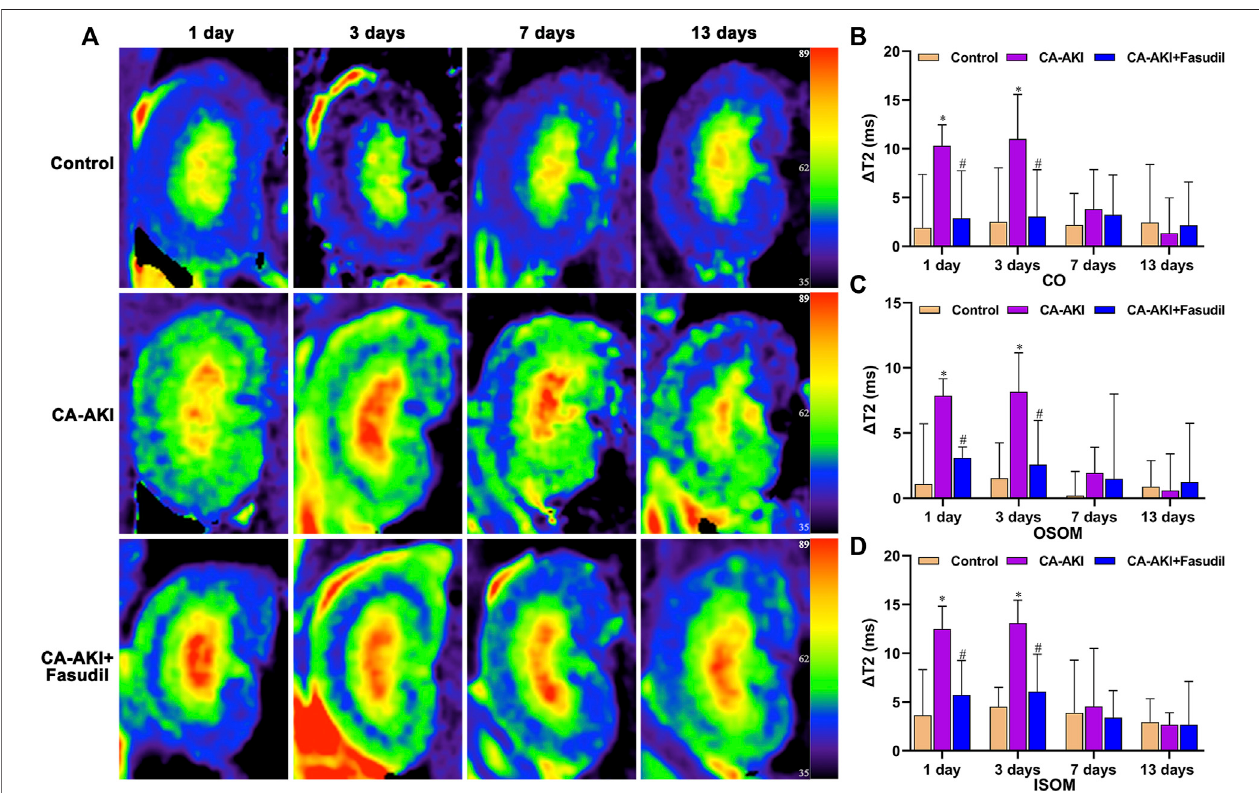
FIGURE 5 | Representative T2 mapping outcomes in three animal groups: (A) Parametric images obtained by T2 mapping and (B – D) quantitative analysis of Δ T2 values at CO, OSOM, and ISOM.* p < 0.05 between CA-AKI/CA-AKI + Fasudil and controls; # p < 0.05 between CA-AKI + Fasudil and CA-AKI. CA-AKI: contrast- associated acute kidney injury; ISOM: inner stripe of the outer medulla; CO: cortex; OSOM: outer stripe of the outer medulla.